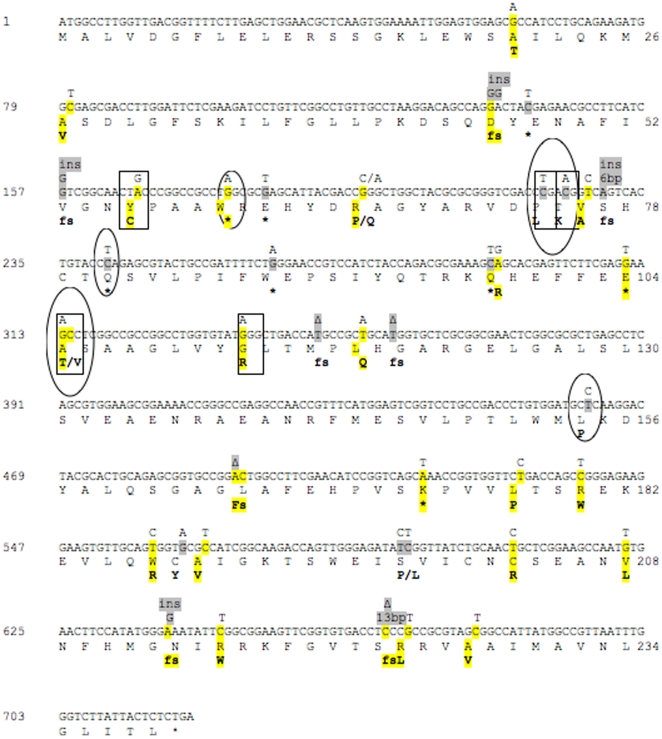
Mutations in the lasR gene (A) and rhlR gene (B) of P. aeruginosa isolates from CF patients.The nucleotide sequence alterations were identified by alignment with the PAO1 sequence. On top of the PAO1 sequence the nucleotide substitutions, insertions (ins) or deletions (Δ) are indicated. Under the amino acid sequence, frame shifts (fs), stop codons(*) or amino acid deletions (Δ) or changes are indicated in bold. The altered nucleotides are shown in yellow if the mutation was complemented with a plasmid containing the wild-type lasR or in grey if not complemented. Amino acid changes that have been previously shown to impair the LasR function [37], [38] are marked in squares and amino acid changes that have been previously described in in vitro studies [22], [39], [48] are encircled.